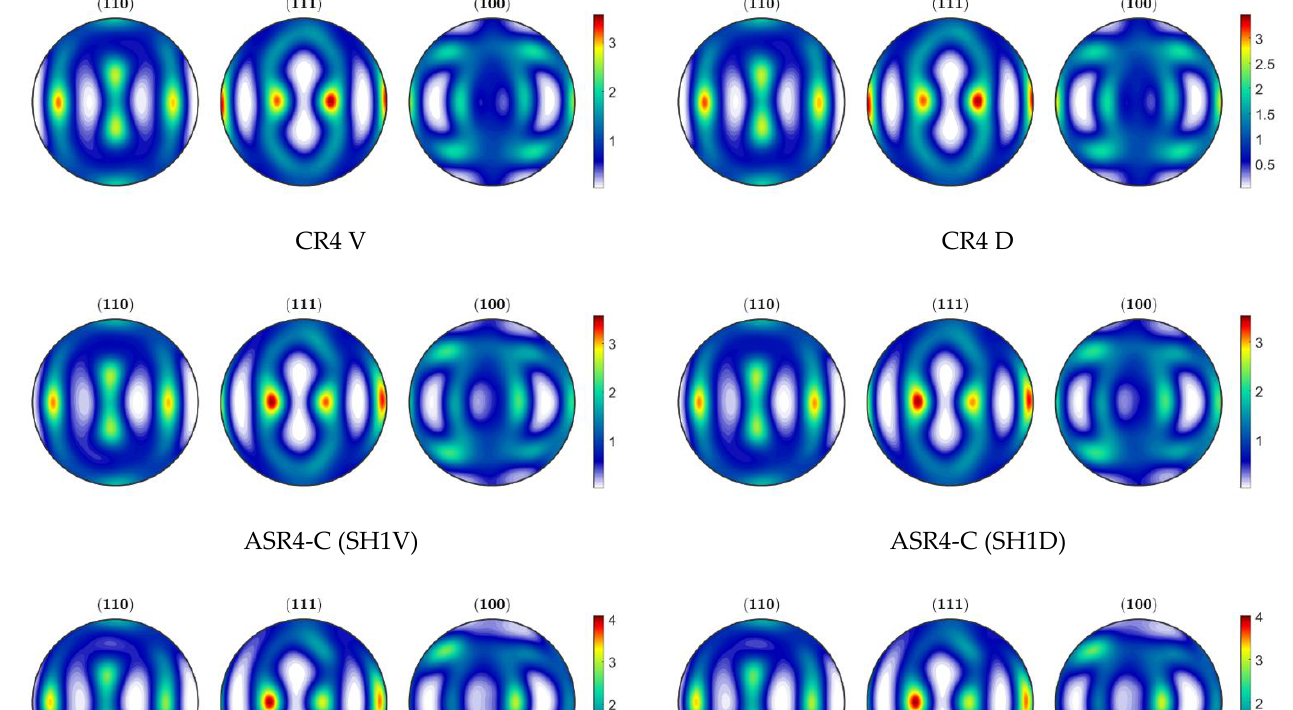
Figure A7. ODF sections for the fourth pass with a 20% thickness reduction per pass.